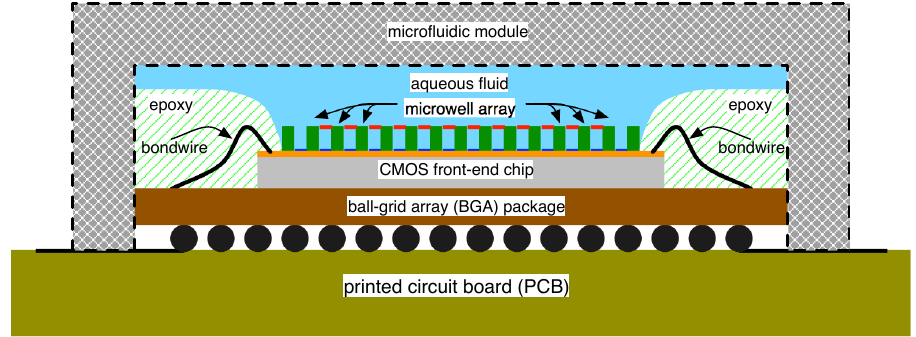
Figure 17. Cross-section of the example construct for connecting the nanopore sensor system to external system